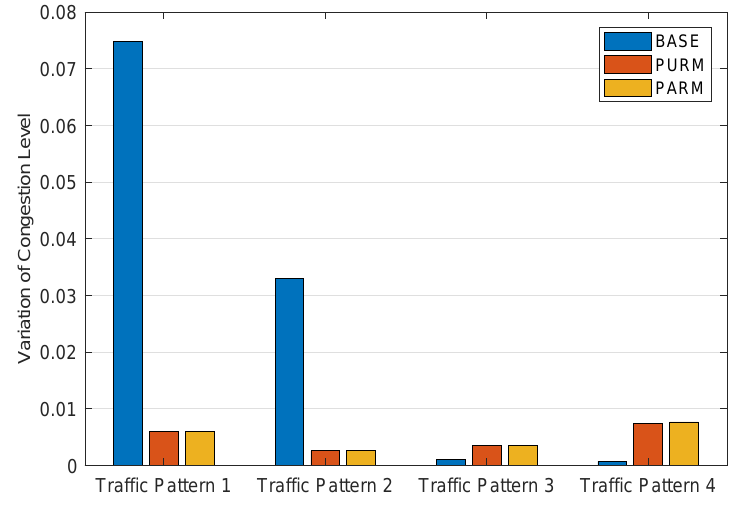
Figure 8. Comparison of variation of CDN